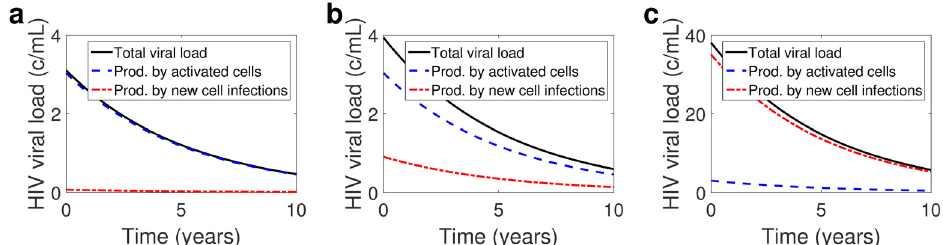
Fig 2. Total HIV RNA copies per mL (black, solid line), on a linear scale, with contributions from activated latently infected cells (blue, dashed line) and from newly infected cells (red, dash-dotted lines) for fraction of infections leading to latency f = 10 − 4 and reproductive ratio (a) ε = 0.99 ( R = 0.023, V 0 (cid:5) 3 copies/mL), (b) ε = 0.9 ( R = 0.23, V 0 (cid:5) 4 copies/mL), and (c) ε = 0.6 ( R = 0.92, V 0 (cid:5) 38 copies/mL). Other parameters set to δ = 1 day − 1 and t L 1 = 2 ¼ 44